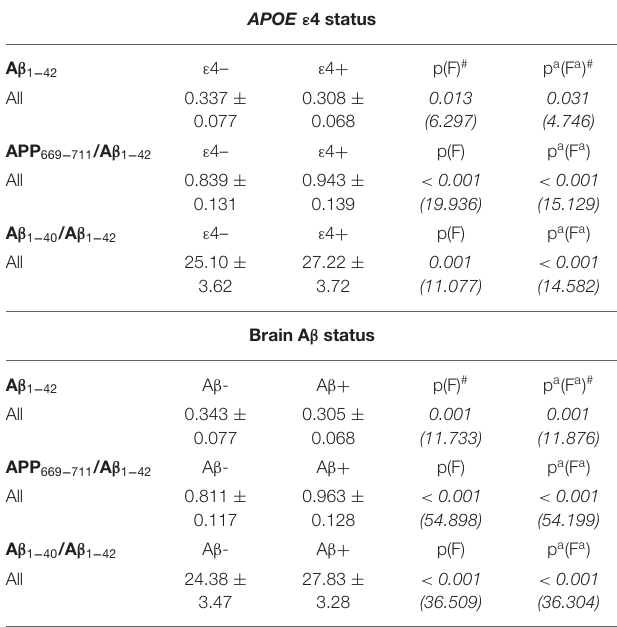
TABLE 3 | Comparison of plasma biomarkers ratios between low-to-moderate physical activity (LMPA) and high physical activity (HPA) groups. LMPA HPA